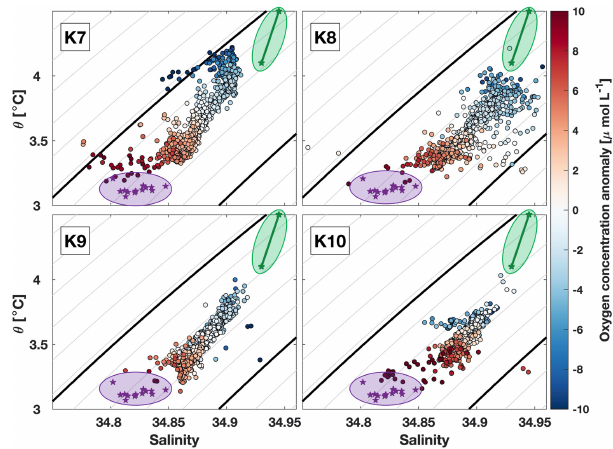
Figure 5. Temperature and salinity diagrams at about 600m nom- inal depth from all four boundary current moorings, showing daily averages. Colors correspond to oxygen anomalies relative to the mean at each instrument, ranging from − 10µmolL − 1 (blue) to + 10µmolL − 1 (red). Purple stars and shading show values from the wintertime mixed layer at the SeaCycler mooring in the inte- rior Labrador Sea (Atamanchuk et al., 2020), and green symbols and shading show typical wintertime conditions of IW near Green- land, taken from Pacini et al. (2020). Potential density ( σ θ ) contours are drawn with a spacing of 0.025kgm − 3 , and solid black contours show densities of σ θ = 27 . 68 and σ θ = 27 . 8kgm − 3